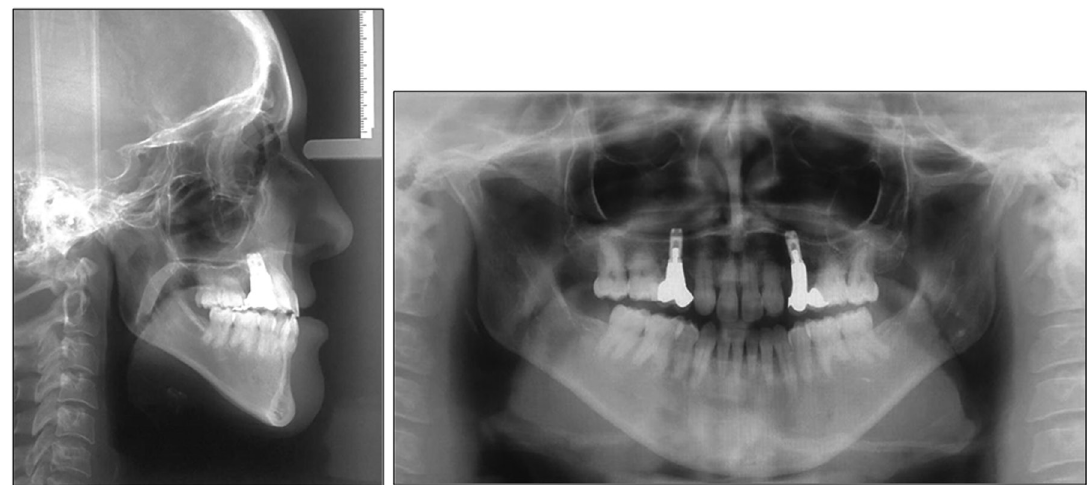
Figure 10. Twenty-four years post-FM cessation lateral cephalogram and orthopantomogram.